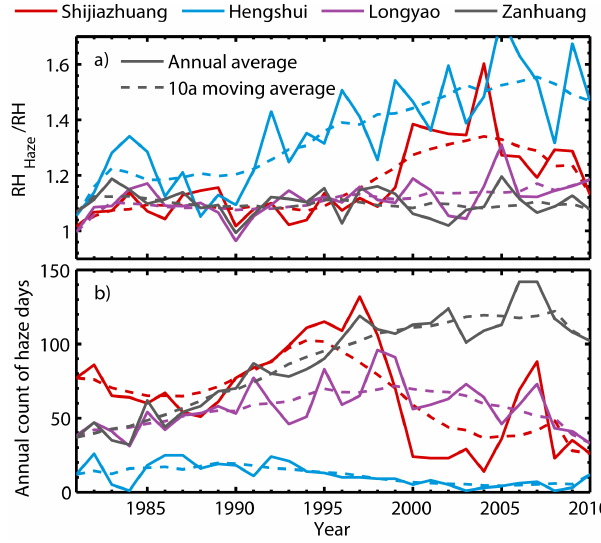
Figure 9. (a) The decadal variation of the haze event associated RH divided by the average RH and (b) the annual number of haze days during the period 1981–2010 at Shijiazhuang, Hengshui, Longyao and